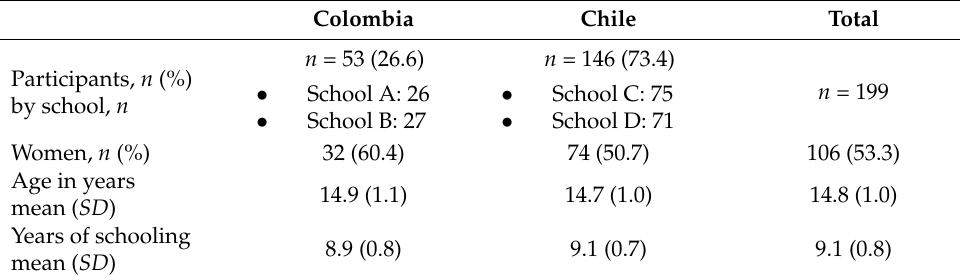
Table 1. Characteristics of participants at baseline in each country.